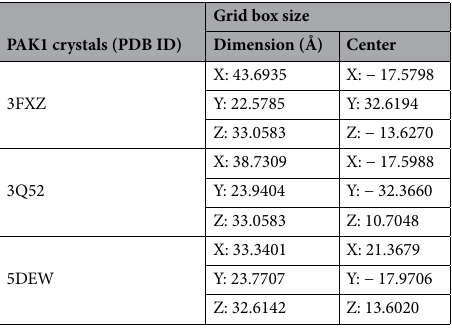
Table 1. Grid box parameters used for docking analysis in this study. Grid box was generated in the hinge region of PAK1 crystal structures.